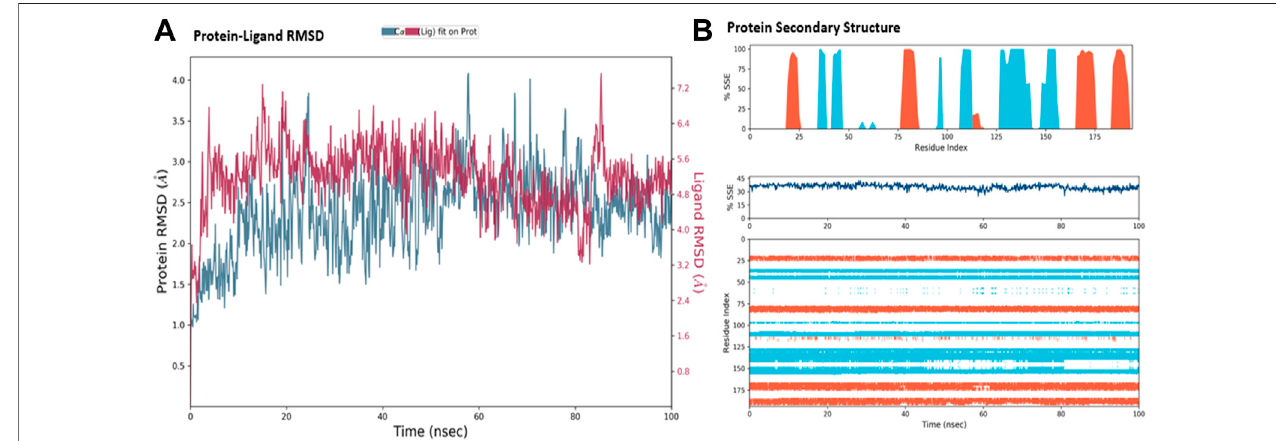
FIGURE4| Molecular dynamicssimulationanalysisofchicoricacid. (A) TheRMSDplotwasobtainedforcompound Chicoric acidcomplexed withSRAdomain of E3 ubiquitin-protein ligase UHRF1(PDB: 3BI7). The 100 ns simulation time reaf fi rmed the stability of the complex without any signi fi cant changes in the structure. (B) Stabilityofthesecondary structureUHRF1overthe100nsofMDsimulation whencomplexedwithChicoricacid.Proteinsecondary structureelements(SSE)likealpha- helices and beta-strands were monitored throughout the simulation. The top plot reported SSE distribution by residue index throughout the protein structure. The middle plot summarized the SSE composition for each trajectory frame throughout the simulation, and the plot at the bottom monitored each residue and its SSE assignment over time.